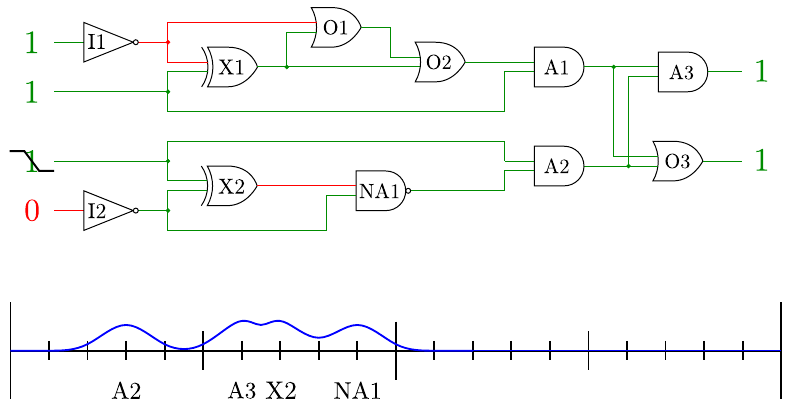
Figure 3: Circuit behavior for exemplary input transition ( p 0 , k 0 , p 1 , k 1 ) = (1 , 1 , 1 , 0) → (1 , 1 , 0 , 0). The timeline shows the occurrence of gate toggles over